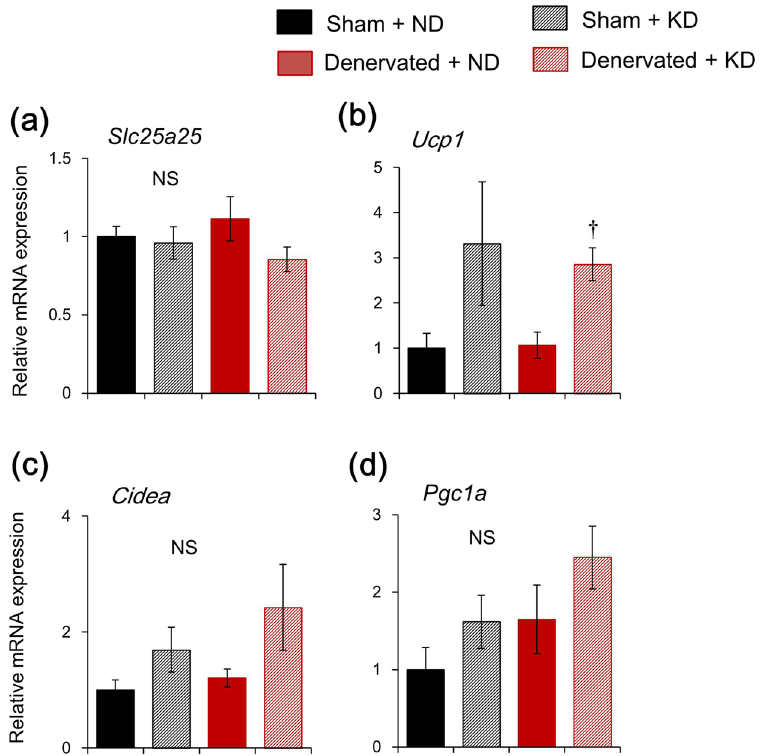
Figure 4. Messenger RNA expression of thermogenic genes in white adipose tissue. Prolonged ketogenic diet (KD) feeding minimally affects thermogenic gene expression in white adipose tissues of mice fed with KD or normal diet (ND) for seven days starting at 10 days after sciatic denervation or sham-operation. Data are expressed as means ± SEM (n = 5 per group). Value for sham-operated mice fed with ND is expressed as 1.0. † P < 0.05 for ND vs. KD. Supplemental Table 4 shows results of statistical